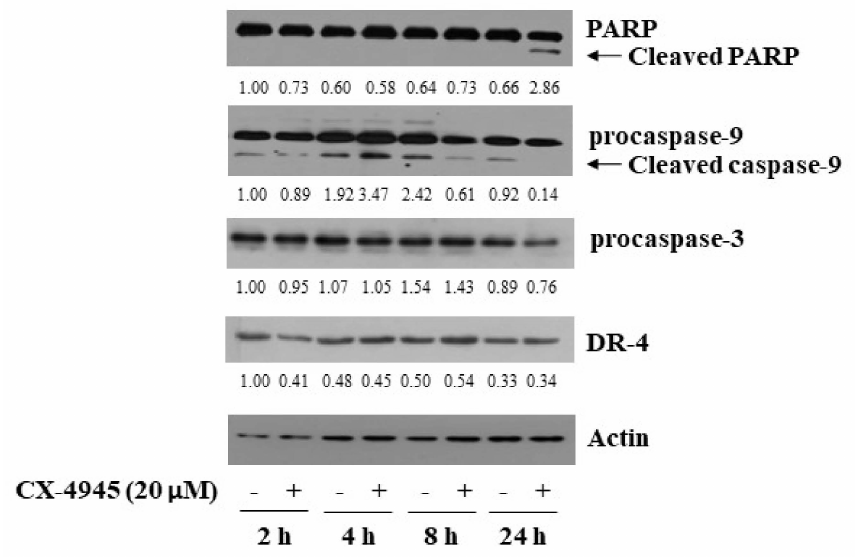
Figure 2. Effects of CX-4945 on the expression of PARP, procaspase-9/3 and DR-4 in HuCCT-1 cells. HuCCT-1 cells were treated with CX-4945 (20 µ M) or vehicle control (DMSO) for the time designated. At each time points, whole cell lysates were prepared and analysed for levels of PARP, procaspase-9, procaspase-3, DR-4 or β -actin by Western